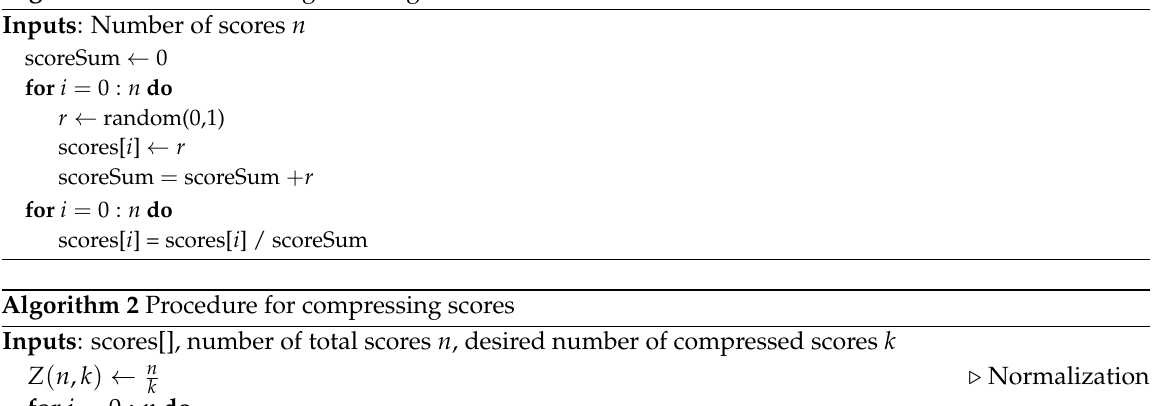
Algorithm 2 Procedure for compressing scores